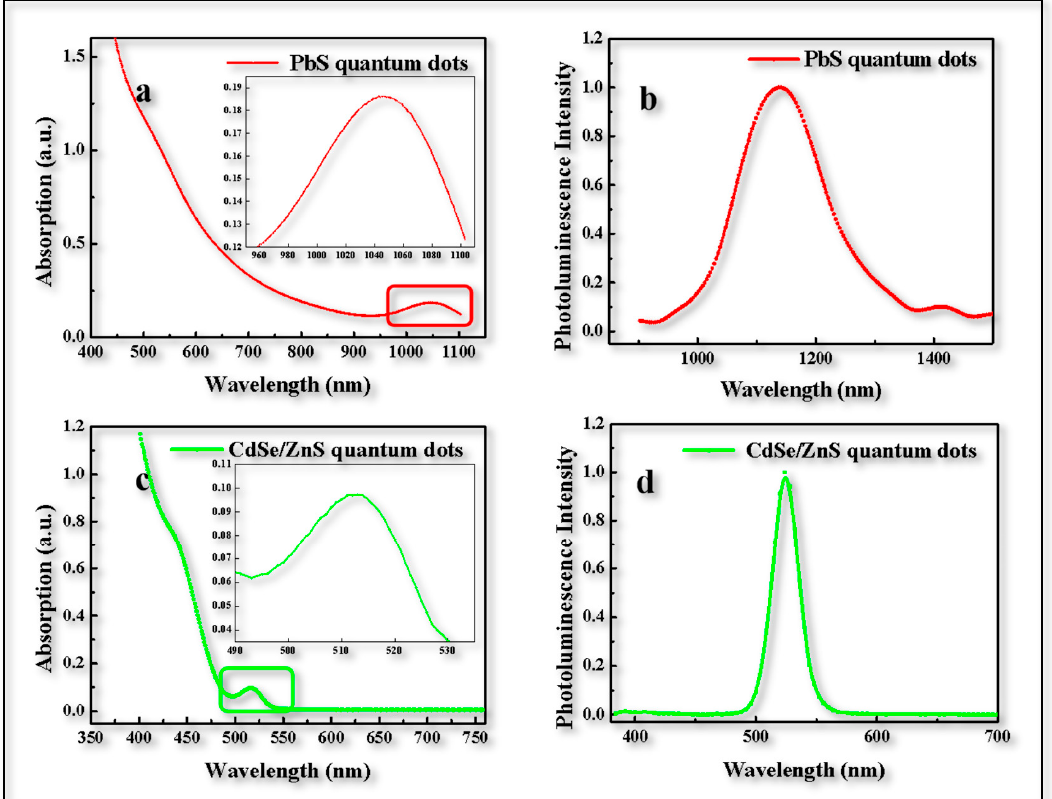
Figure 1. Quantum dot characterization. ( a ) Absorption spectra of PbS QD film, inset is detail view of peak position. ( b ) PL spectra of PbS QDs film. ( c ) Absorption spectra of CdSe/ZnS QDs film, inset is a detailed view of the peak position. ( d ) PL spectra of CdSe/ZnS QDs film.